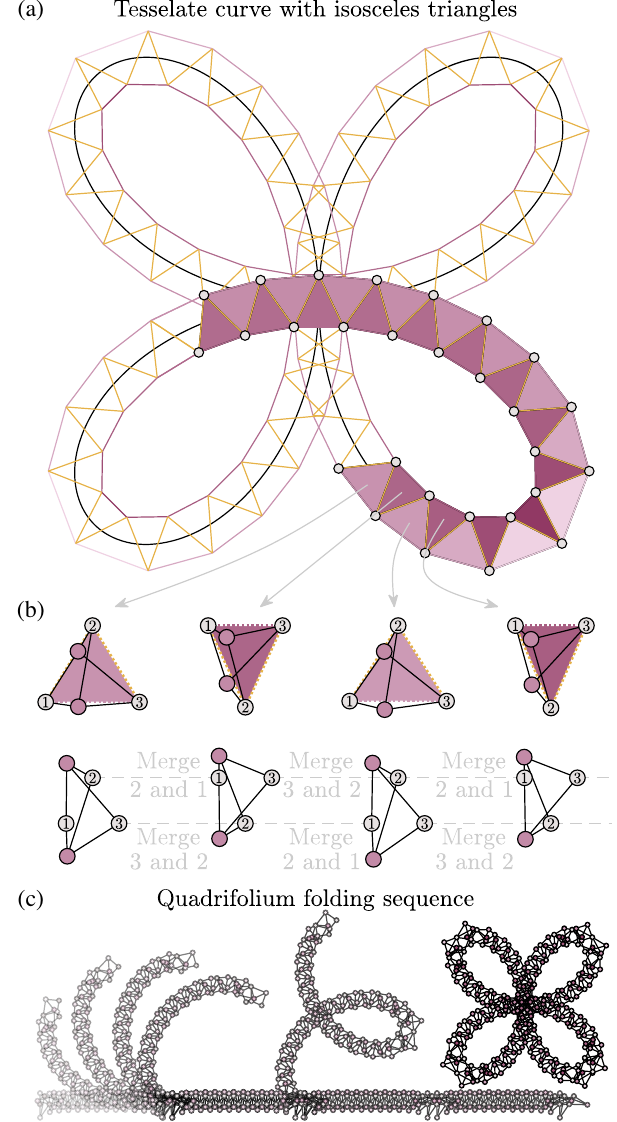
FIG. 9. Designing precise network geometry. (a) To design a network chain that forms a desired curve, we tessellate the curve with isosceles triangles, where each triangle represents a unit. The gold edges represent l k and l k , while the purple edges þ 1 represent c . (b) The units are then constructed by placing extra nodes along the solution space defined by the start and end positions (Sec. IV B). Then, the units are combined into a chain by merging nodes (Sec. IV C). (c) The resulting network consists of nonidentical units that have different bond lengths, and thereby, the network has nonperiodic structure. However, because all units are designed to share the same start fixed point l (cid:129) and end fixed point l ∘ , the network starts at a periodic state at l k ¼ l (cid:129) and undergoes one conformational motion to form the desired curve at the second periodic state l k ¼ l ∘